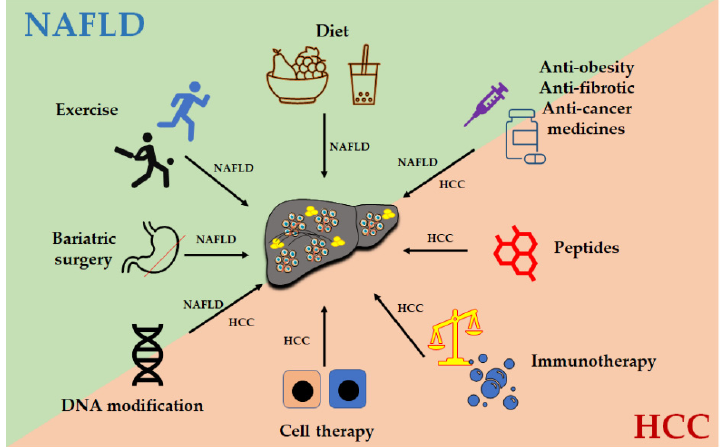
Figure 3. Treatment options for NAFLD-related HCC. Abbreviations: NAFLD: nonalcoholic fatty liver disease; NASH: nonalcoholic steatohepatitis; HCC: hepatocellular carcinoma.